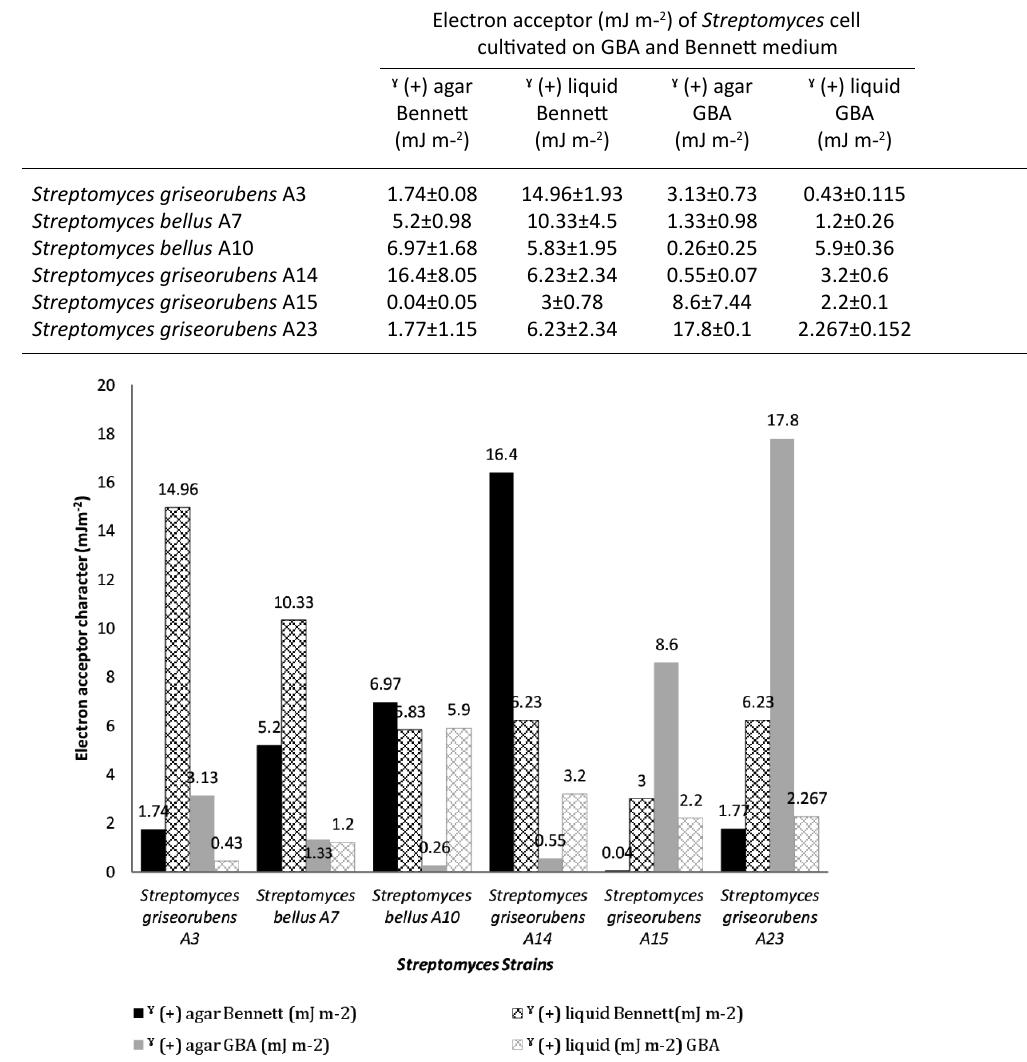
Table 4. Electron acceptor of Six Streptomyces strains (in mJ m- 2 ),grown in Bennett liquid, agar Bennett, GBA liquid, and agar GBA media Electron acceptor (mJ m- 2 ) of Streptomyces cell cultivated on GBA and Bennett medium